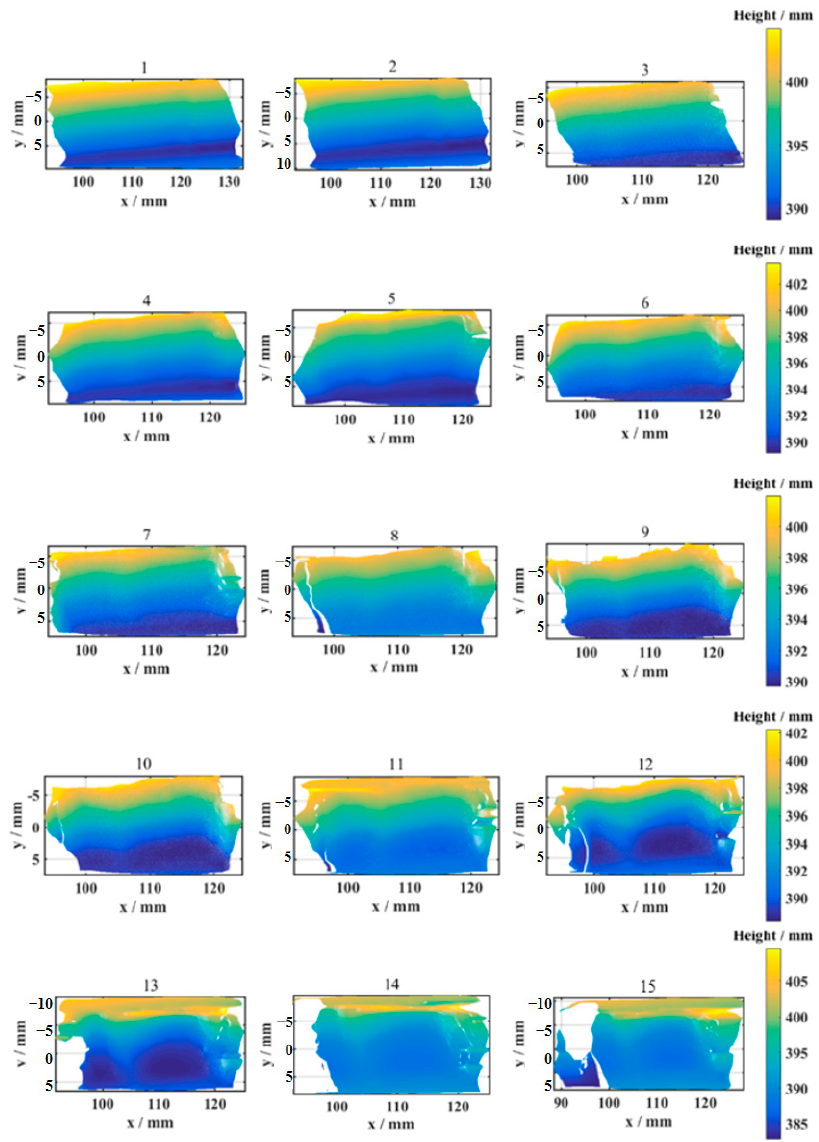
Figure 13. Measured 3D shape for different print layer.